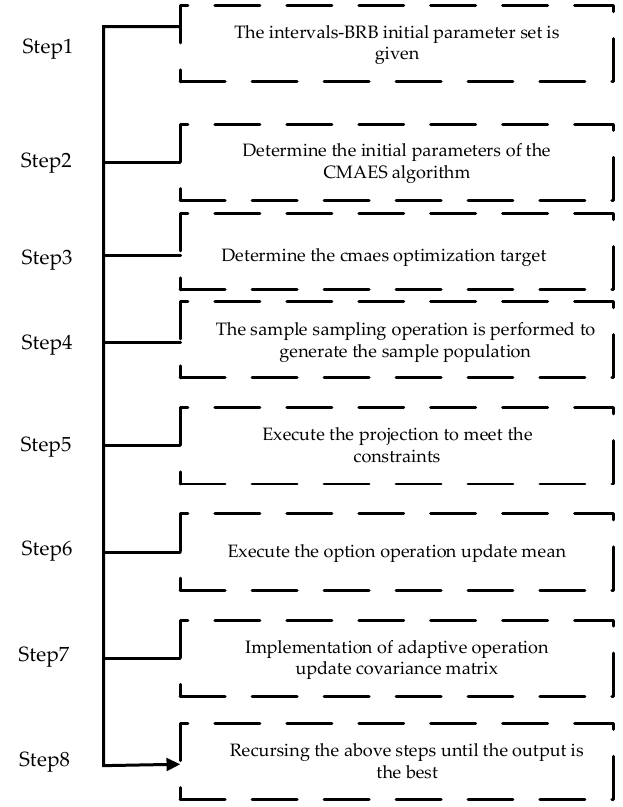
Figure 3. The process of optimizing the intervals-BRB